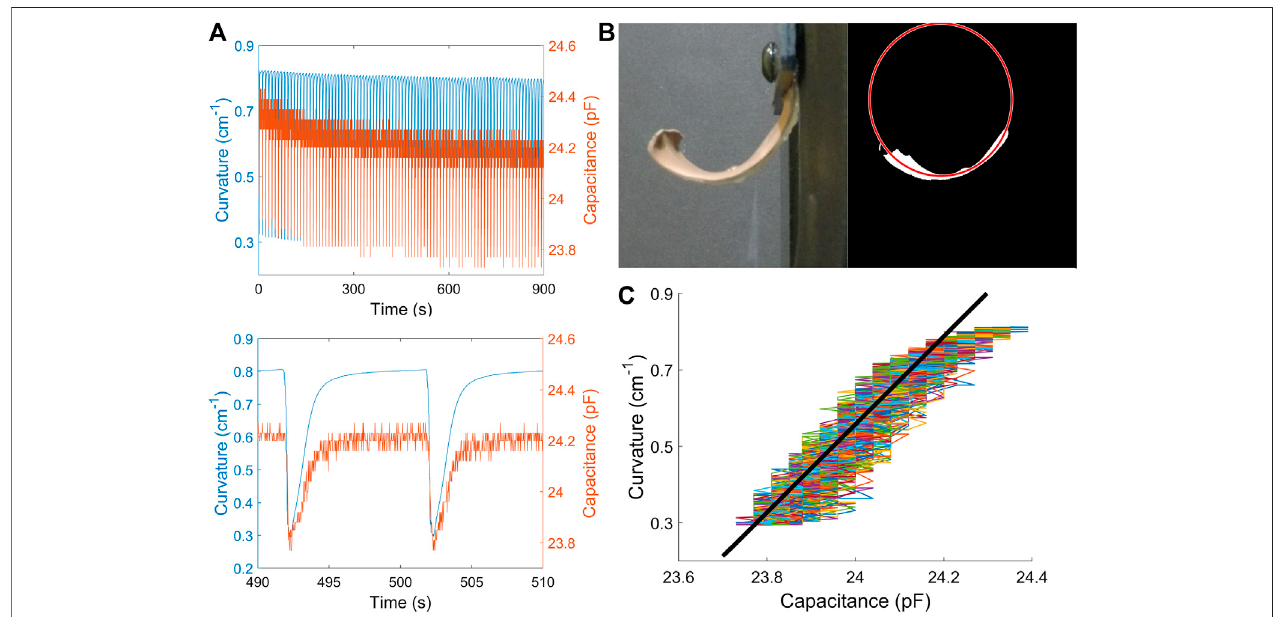
FIGURE3| Straingaugecalibration. (A) Curvatureandcapacitancedataintimeseriesduringonetestperiod (up) andtwocycles (down) . (B) The fi ttedcircleusing Pratt method in image processing. Curvature is calculated as the inverse of the radius of the fi tted circle. (C) Linearly relationship between curvature and capacitance during the cooling time. All data were collected under the con fi guration of voltage as 8 V and activation time as 0.15 s.